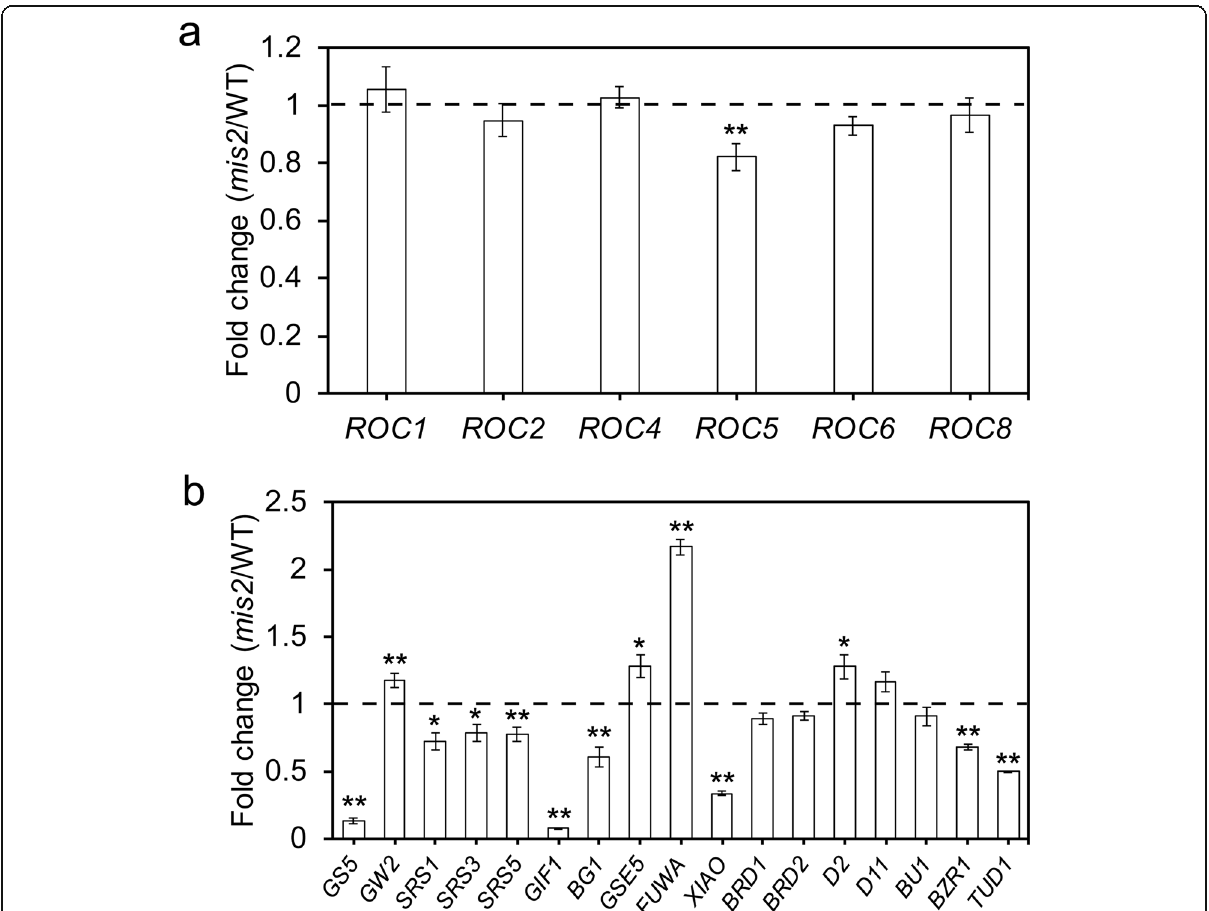
Fig. 8 Quantitative RT-PCR analysis of epidermal cell development, grain size and BRs related genes. ( a ) Relative expression fold change of ROC5 and related genes in WT and mis2 . ( b ) Relative expression fold change of genes related to grain size and BRs in WT and mis2 . Young inflorescence of ~ 1 cm was used for analysis. Rice ubiquitin gene was used as an internal control. ** P < 0.01 and * P < 0.05 by Student ’ s t test. Values are given as mean ± SD ( n =